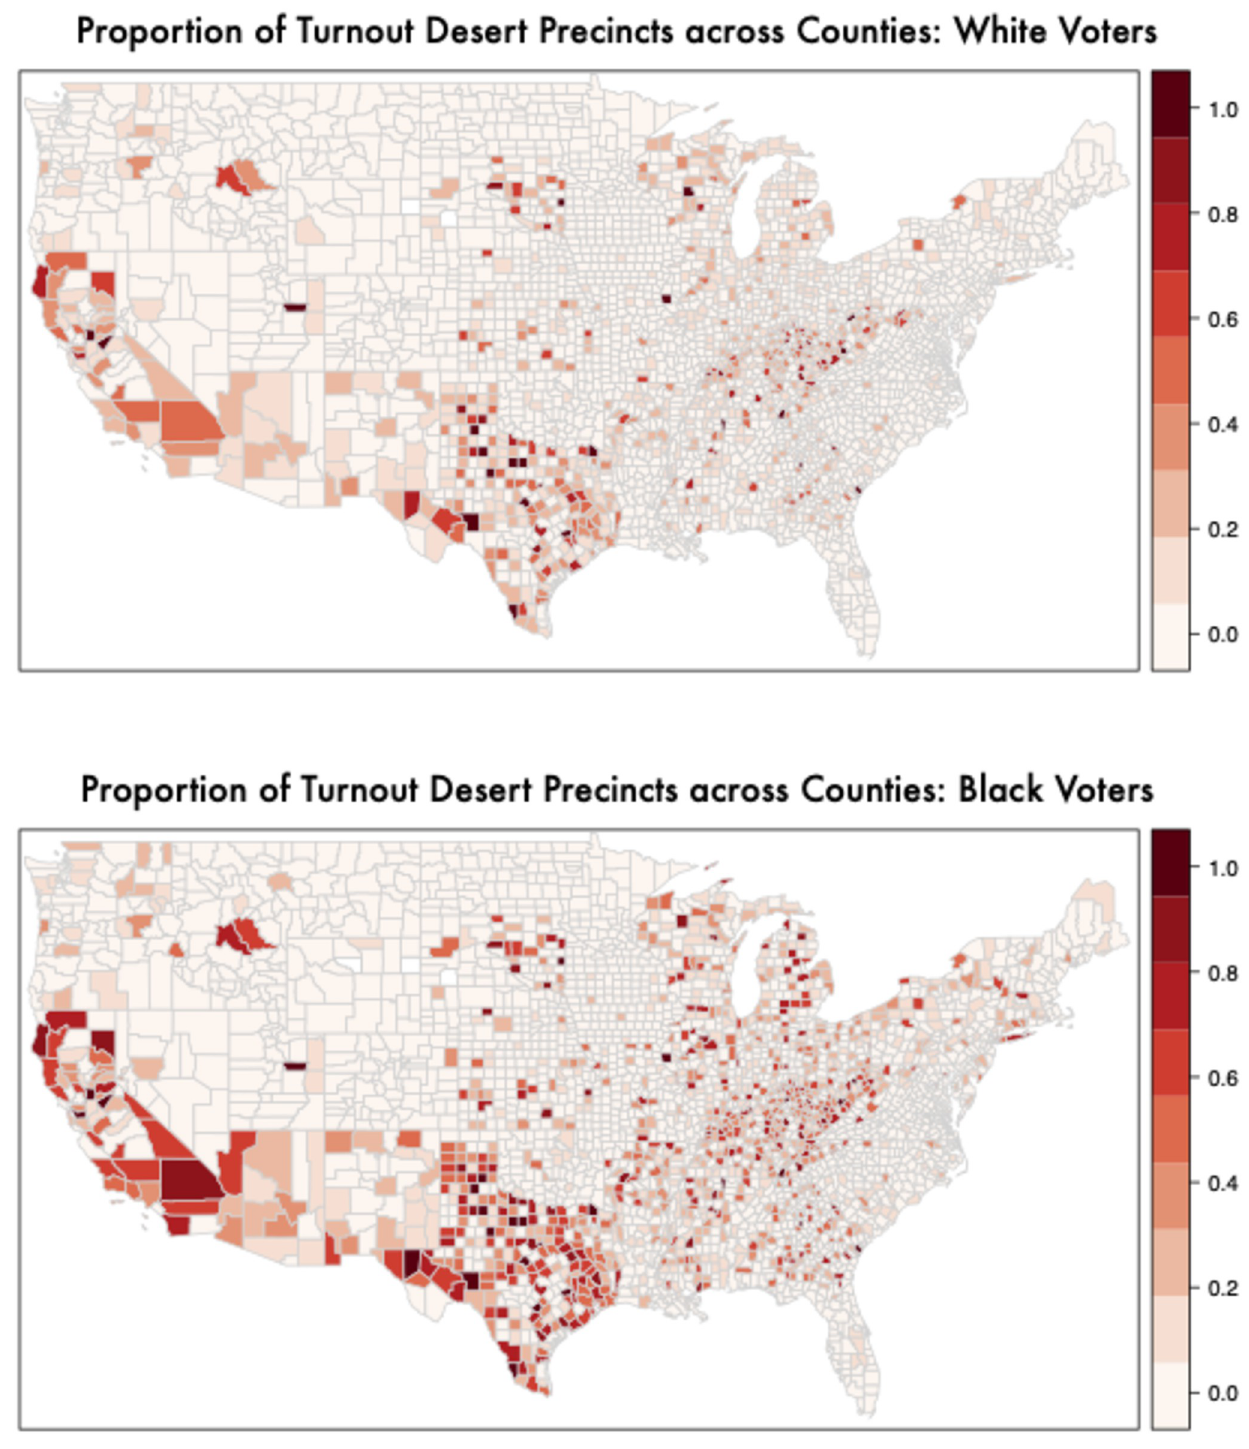
Fig 3. Mapping turnout deserts by racial groups (1) proportion of turnout desert precincts in a county by race (i.e. 1 standard deviation below the national average in voter turnout in 2016). The top panel shows among precincts where White voters live; the second panel shows among precincts where Black voters live. Black (25.8%) individuals are more than 3 times more likely to live in a turnout desert precinct than white voters (8.3%). Minorities’ turnout deserts are spread across large/urban and small/rural locations. S13-S20 Figs in S1 File show similar maps for all groups in 2014 in addition to different definitions of turnout